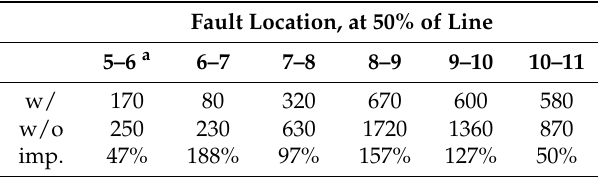
Table 2. CCT (ms) results under different fault locations.